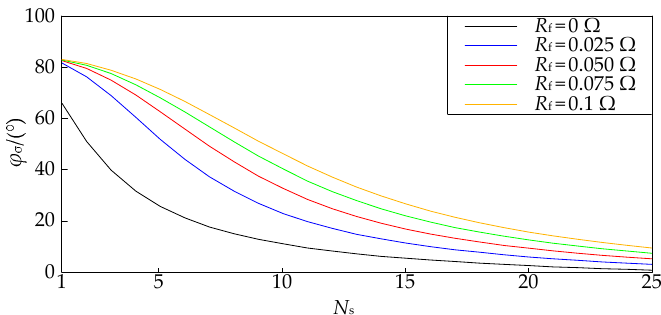
R and f R and f R and f